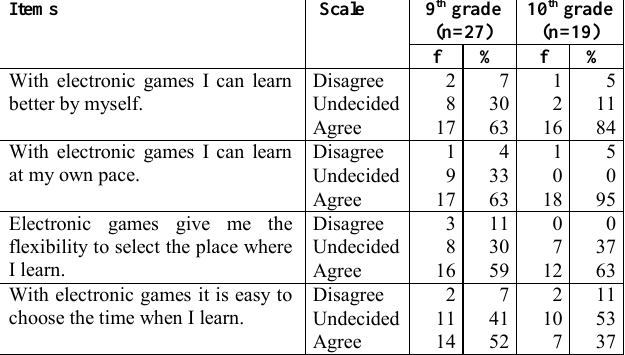
Table 7. Students attitude toward the use of